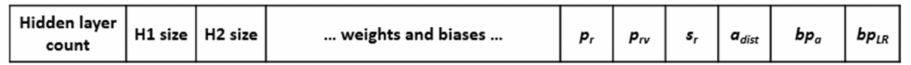
Figure 5. The extended variables of each country with added self-adaptive